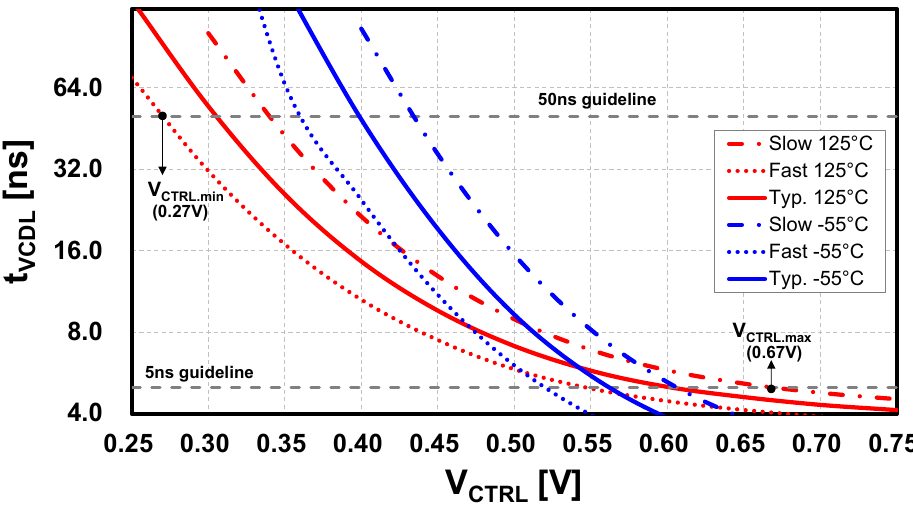
Figure 9. Characteristics of the delay of the VCDL according to V CTRL , temperature, and process corner to design the output swing range of charge pump.